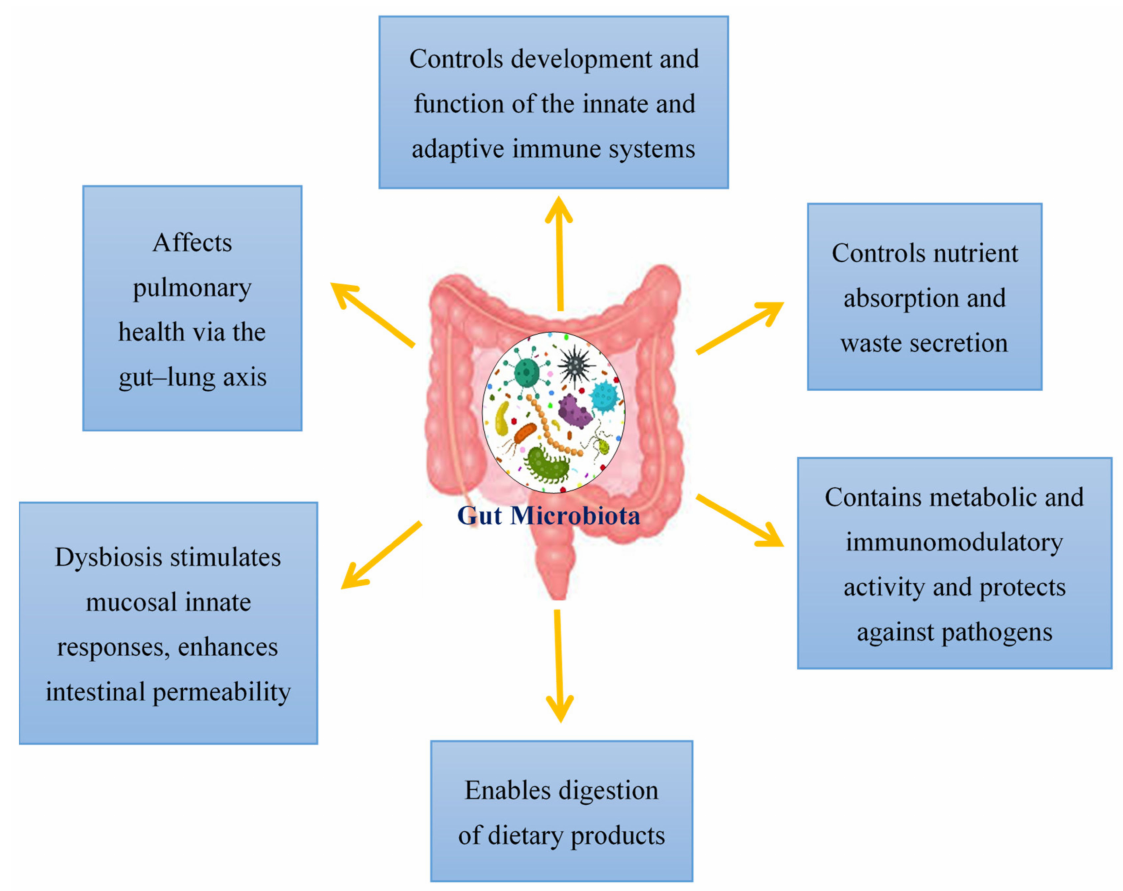
Figure 1. An overview of the functions of the gut microbiota in the